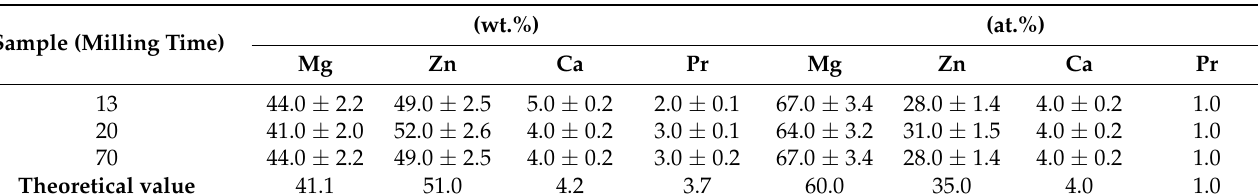
Table 7. EDS (energy dispersive spectroscopy) results from the selected Mg-Zn-Ca-Pr alloy sintered samples milled for 13, 20, and 70 h, respectively.